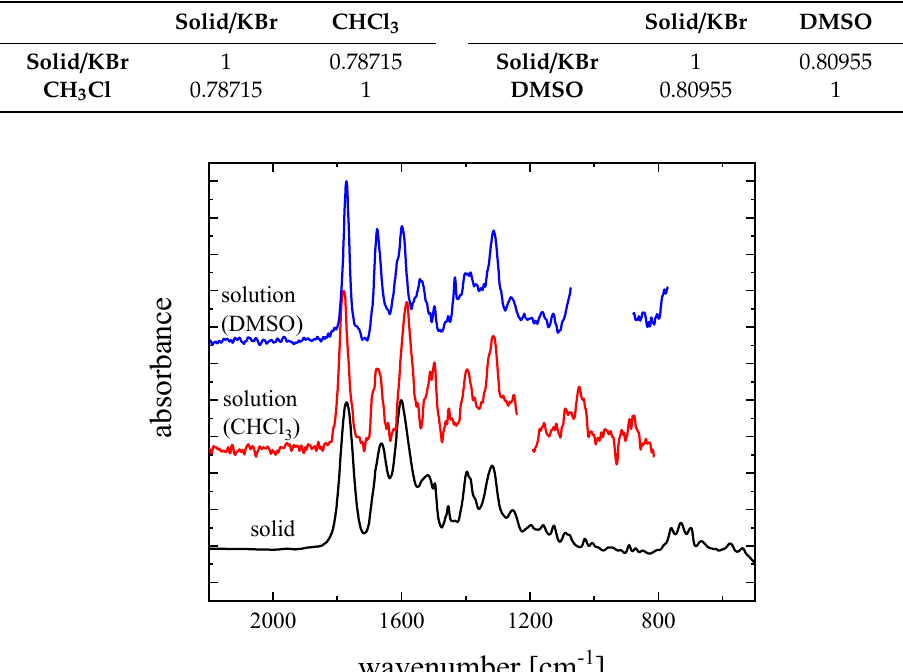
Table 1. Pearson correlation coefficients for solid and solution with CHCl 3 or DMSO used as solvents. Solid / KBr